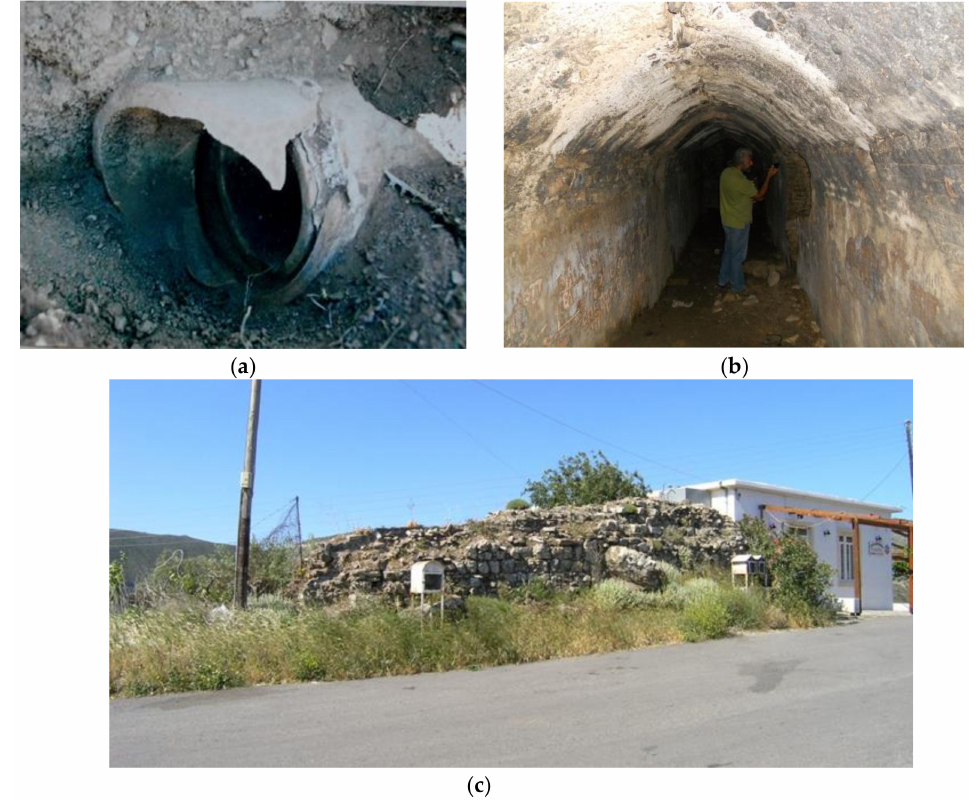
Figure 14. Aqueduct of Elyros: ( a ) Remnants of the aqueduct; Junction of clay pipes and ( b ) cistern and ( c ) wall carrying the water channel (Photos taken by Y.